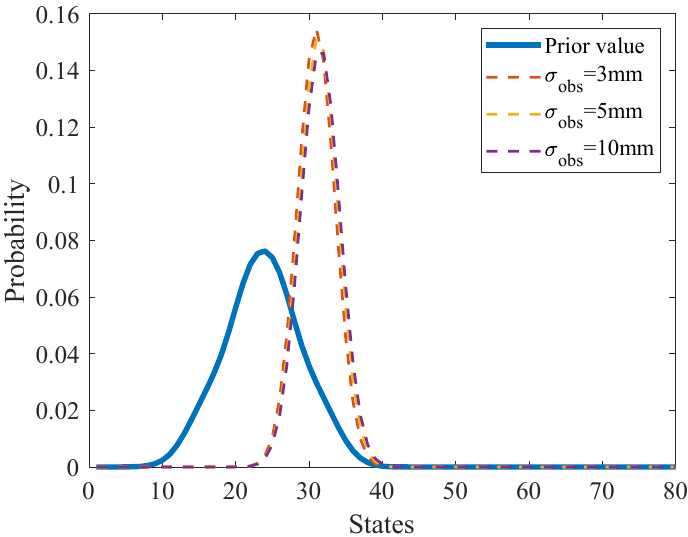
Figure 16. Posterior probability distribution of the EICS inferred from the field inspection results.